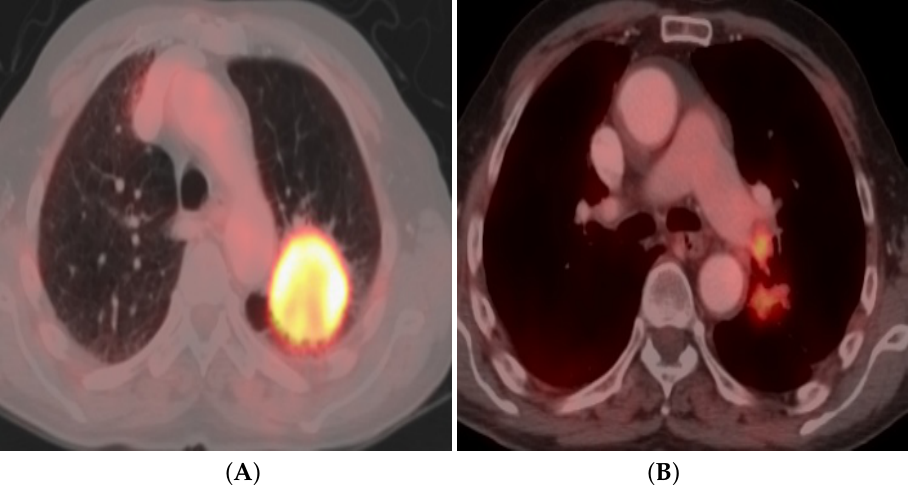
Figure 2. A 65-year-old male cigarette smoker with bronchogenic large-cell carcinoma. Axial- fused FDG PET/CT image ( A ) reveals FDG-avid large left upper lung lobe mass (5.5 × 6 cm) with maximum standardized uptake value (SUVmax) of 11.8. Axial-fused FDG PET/CT image at distal level ( B ) reveals FDG-avid ipsilateral hilar LN with SUVmax 7. No FDG-avid distant metastatic deposits, imaging-based staging IIIA (T3 N1